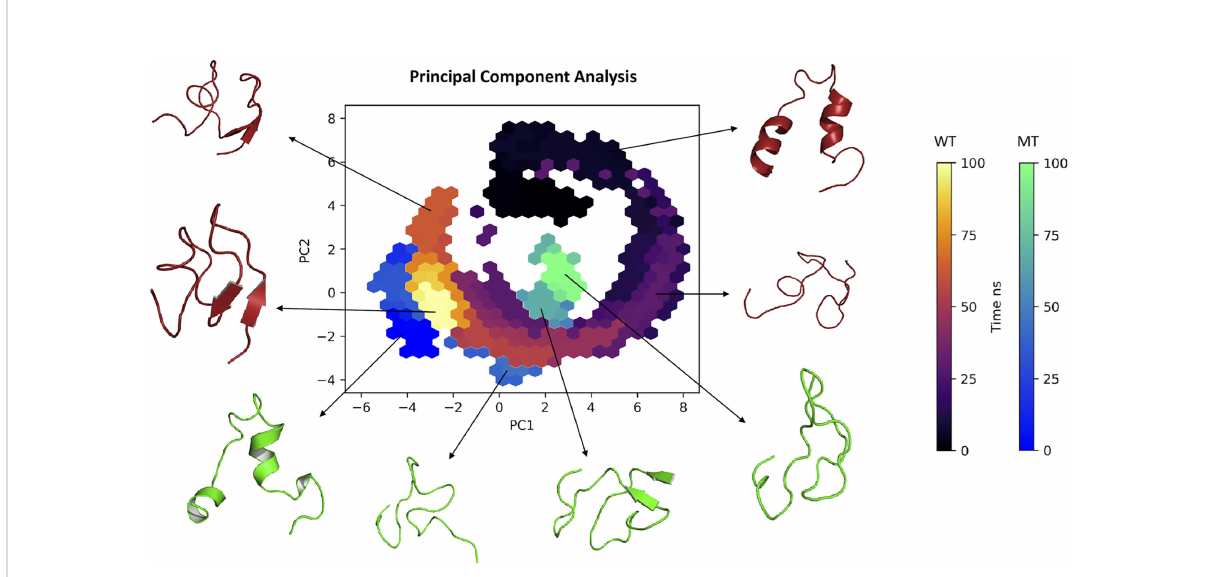
FIGURE 4 Principal component analysis (2D) clustering of various snapshots of the simulation trajectory based on respective Cartesian